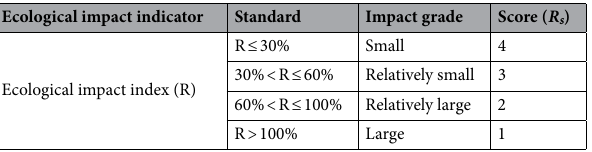
Table 3. Evaluation indicator and criteria of ecological impact for pollutant